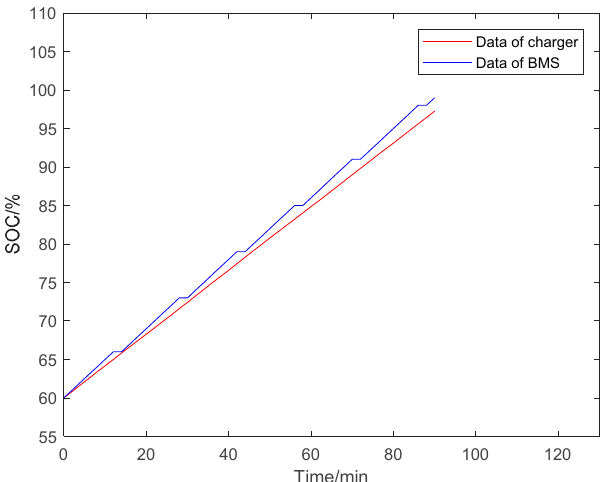
Figure 11. Comparison of state of charge (SOC) calculation data of battery model with SOC data provided by BMS (Battery Management System).